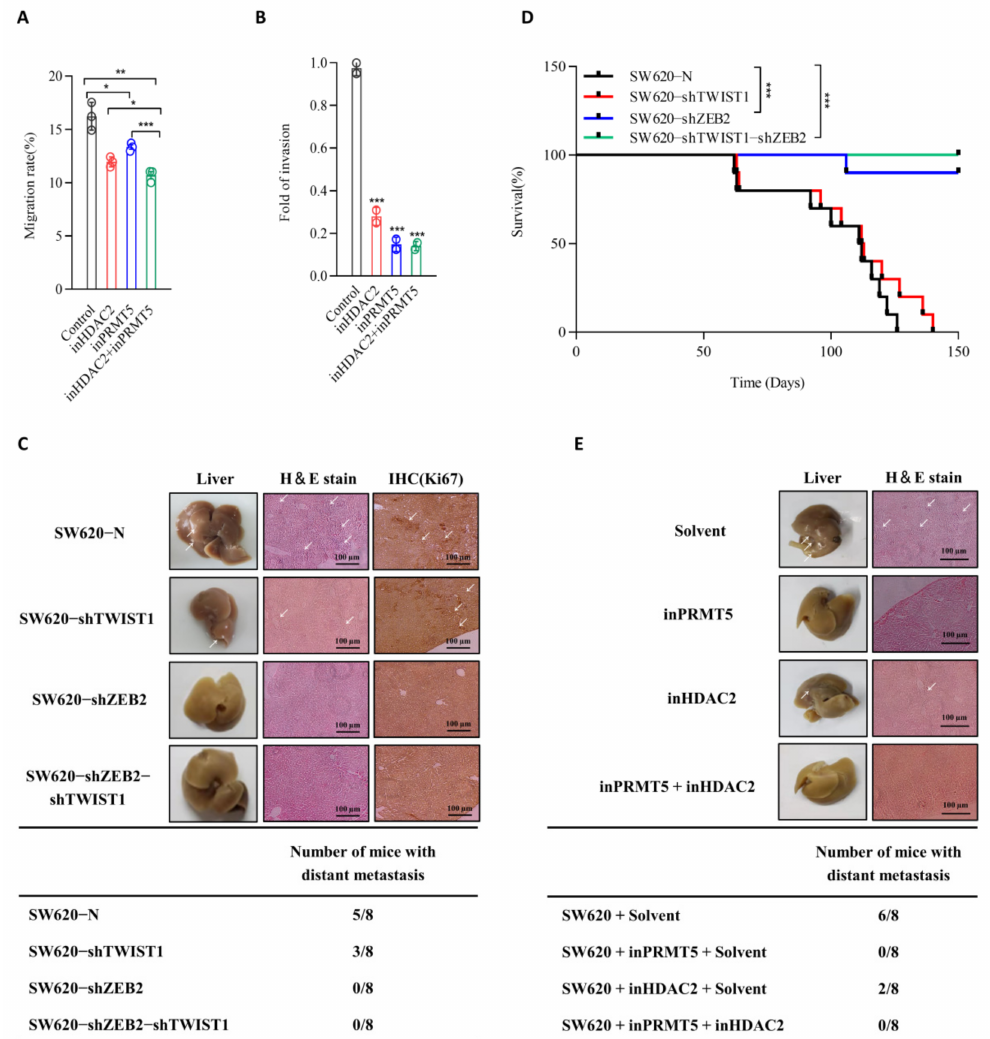
Figure 6. PRMT5 and HDAC2 are responsible for the migration, invasion, and metastasis triggered by ZEB2 in CRC cells. ( A , B ) Analysis of wound healing assays of the migratory ability and transwell invasion assays of the invasiveness of SW620 cells treated with GSK3326595 (PRMT5 inhibitor) and Santacruzamate A (HDAC2 inhibitor). Statistical analysis of migration and invasion are shown in the bar graph (mean ± SD from three independent experiments). ( C ) Total number of mice with distant metastasis 40 days after injection of SW620-shZEB2, SW620-shTWIST1, SW620-shZEB2- shTWIST1, and SW620 control cells. SW620-shZEB2, SW620-shTWIST1, SW620-shZEB2-shTWIST1 and respective SW620 control cells were injected into nude mice. After 40 days, the mice were sacrificed and their livers were dissected. Liver metastatic nodules were examined macroscopically, and paraffin-embedded sections were subjected to H&E and Ki67 staining. Arrowheads indicate liver metastases. Phase contrast images were taken at × 4 magnification. ( D ) A total of 2 × 10 6 SW620 were injected into the tail veil of nude mice. Metastasis was suppressed by GSK3326595 or Santacruzamate A treatment 35 days after injection. The survival time of the mice was analyzed by Kaplan–Meier survival analysis. ( E ) Total number of mice with distant metastasis 40 days after injection of SW620 cells with GSK3326595 and Santacruzamate A. SW620 cells, GSK3326595 and Santacruzamate A treatments were injected into nude mice. After 40 days, the mice were sacrificed and their livers were dissected. Liver metastatic nodules were examined macroscopically, and paraffin-embedded sections were subjected to H&E staining. * p ≤ 0.05; ** p ≤ 0.01; *** p ≤